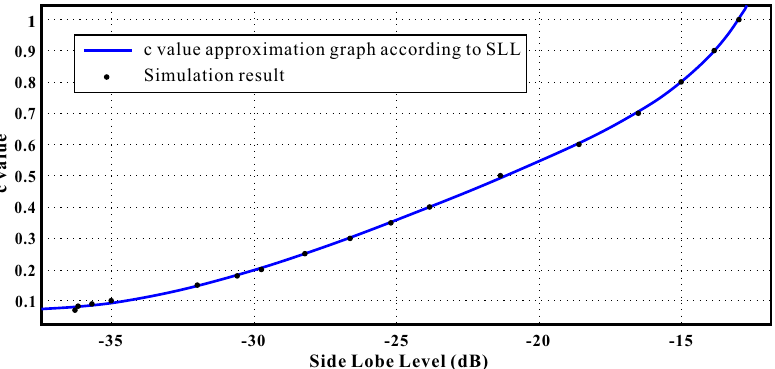
Figure 11. Approximate graph of c -value according to sidelobe